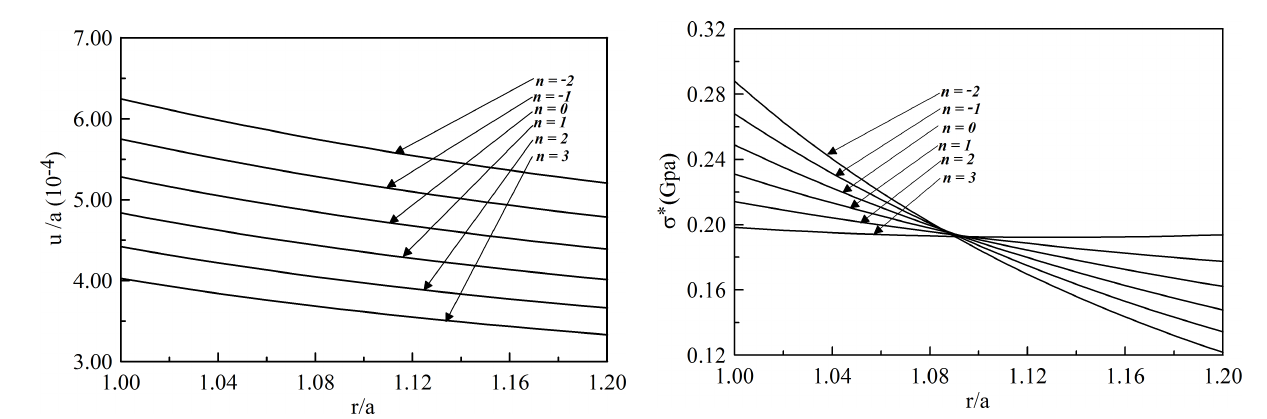
Figure 19: Radially distributed tangential stress